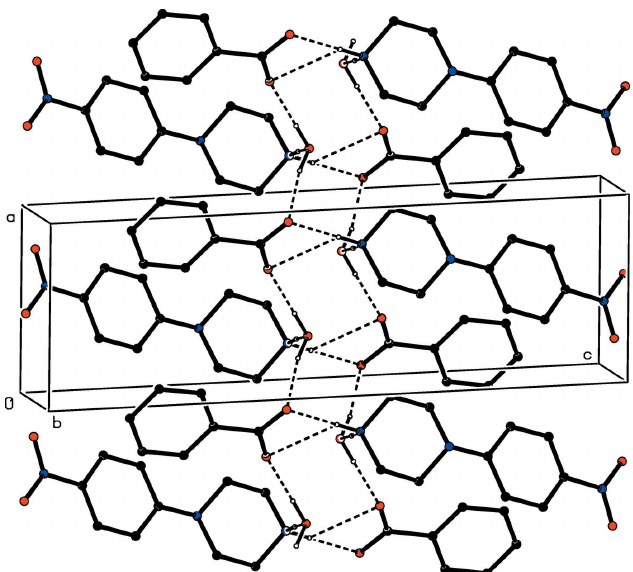
Figure 3 Part of the crystal structure of compound (I) showing the formation of a chain of hydrogen-bonded rings running parallel to the [100] direction. Hydrogen bonds are drawn as dashed lines and, for the sake of clarity, the H atoms bonded to C atoms have all been omitted.